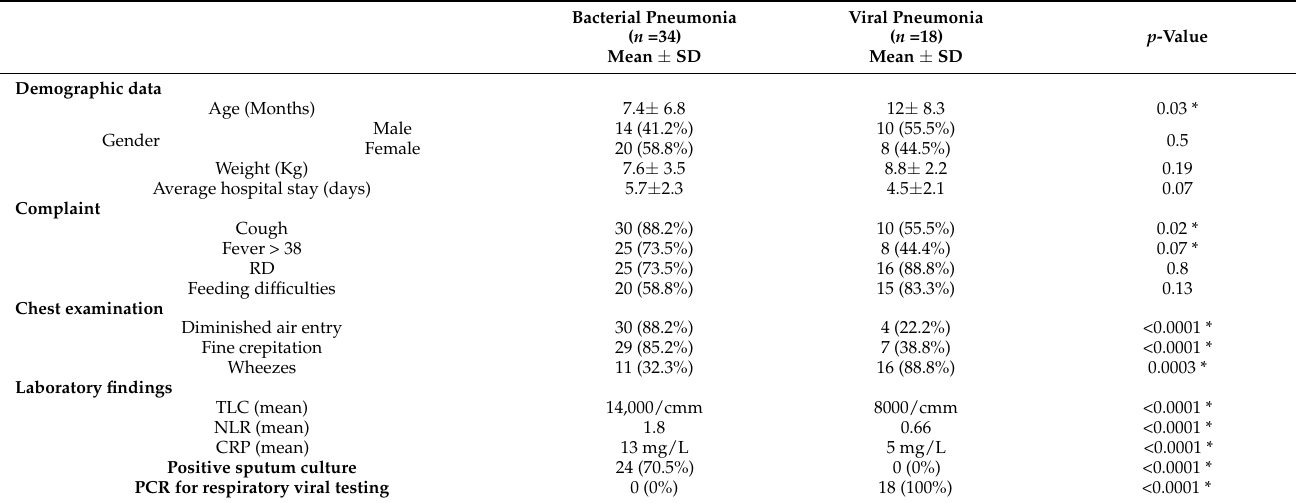
Table 1. Baseline patient characteristics.